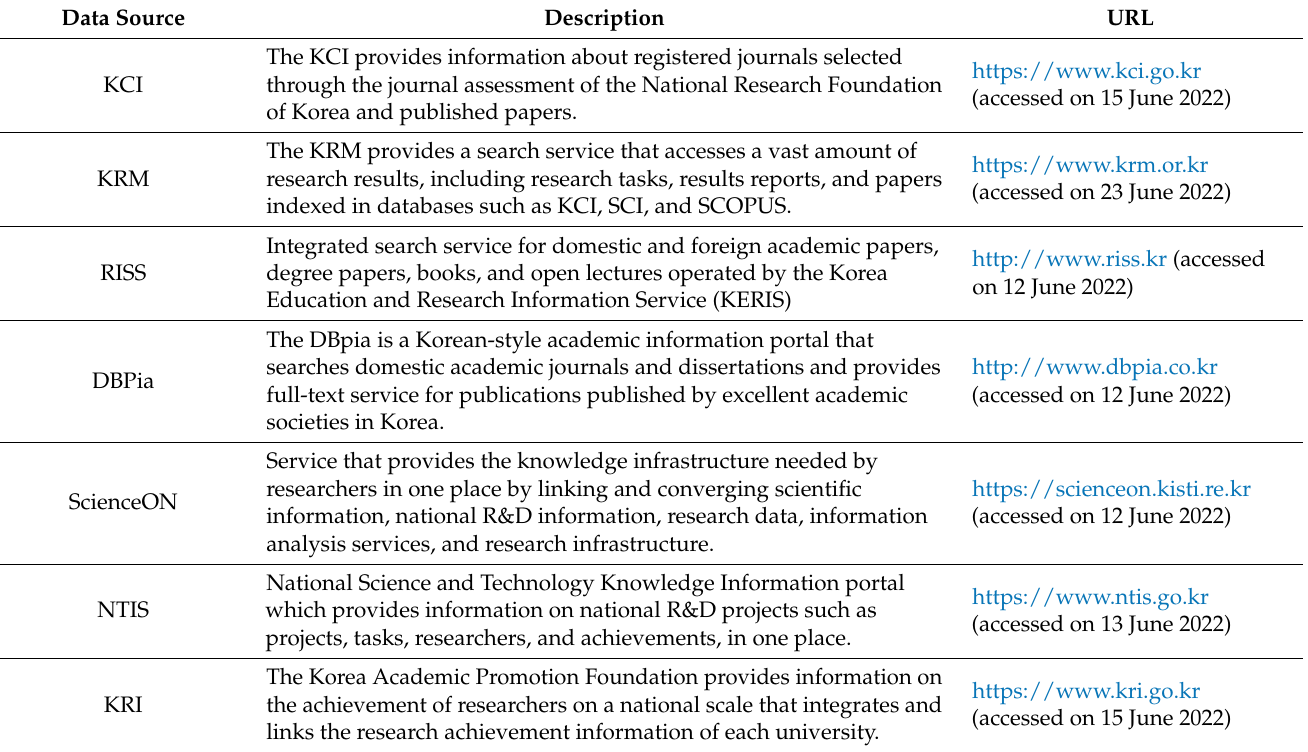
Table 1. Summary of the data sources in Korea.